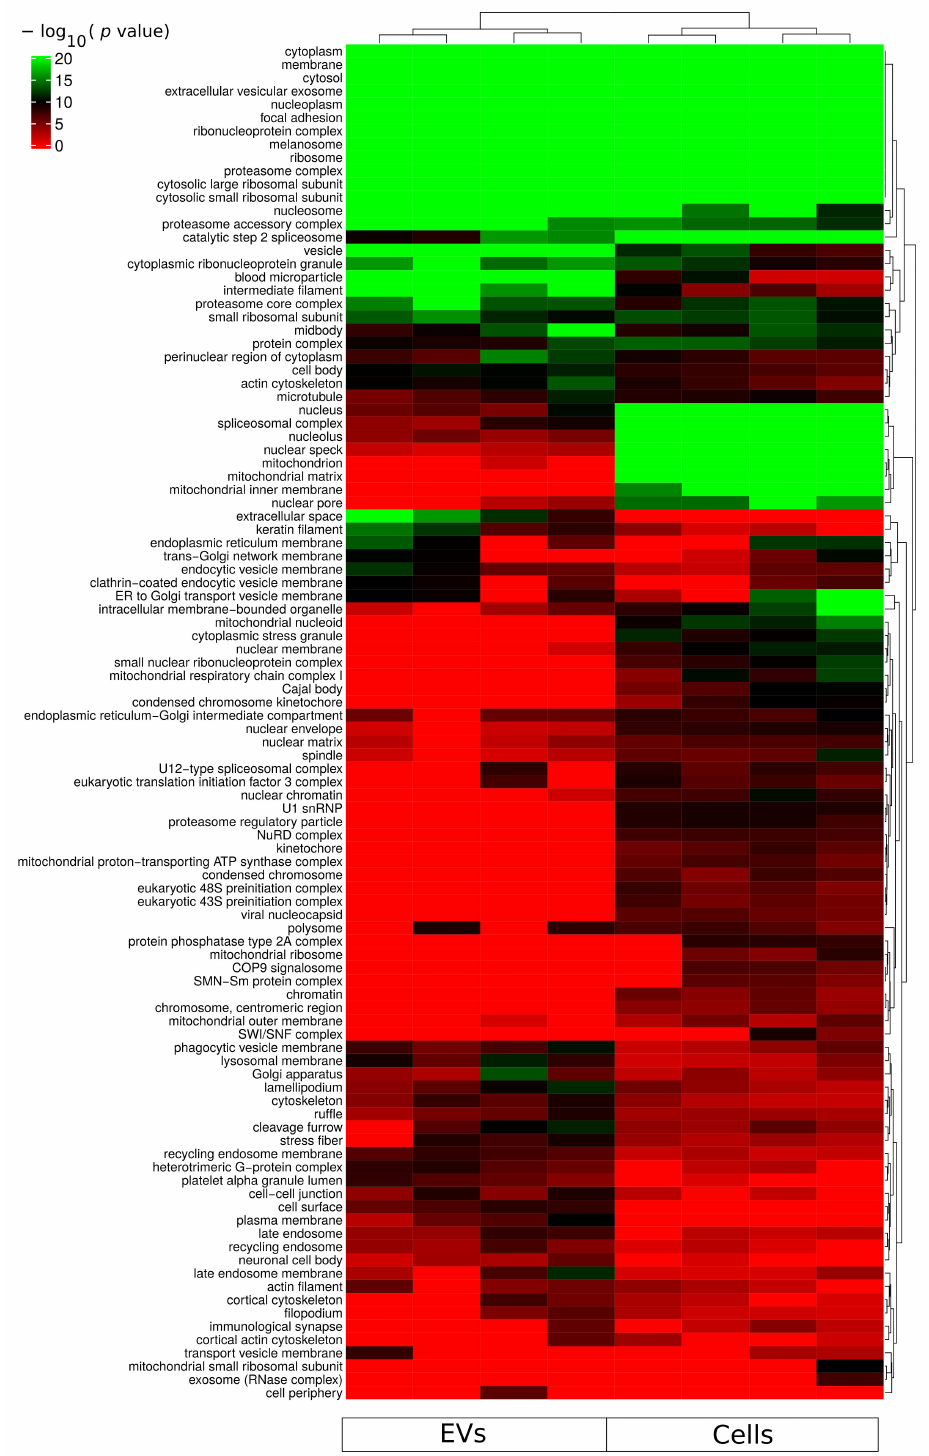
Figure 3. Functional enrichment for cellular component using all identified proteins from each sample group (cells and sEVs). A hypergeometric p -value threshold of 10 − 6 of at least one sample group was applied for construction of the heat